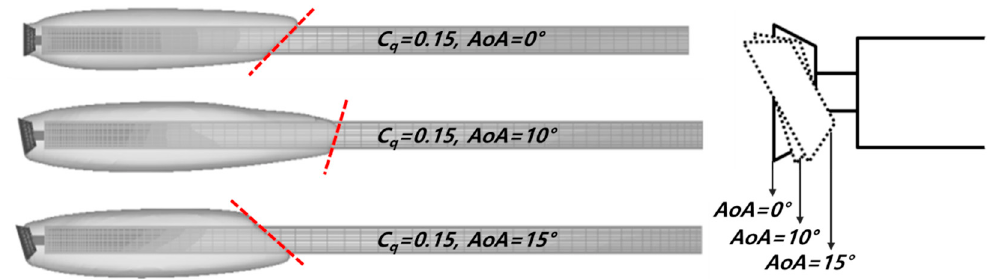
= 0.15, angle of attack = 0, 10, 15 ◦